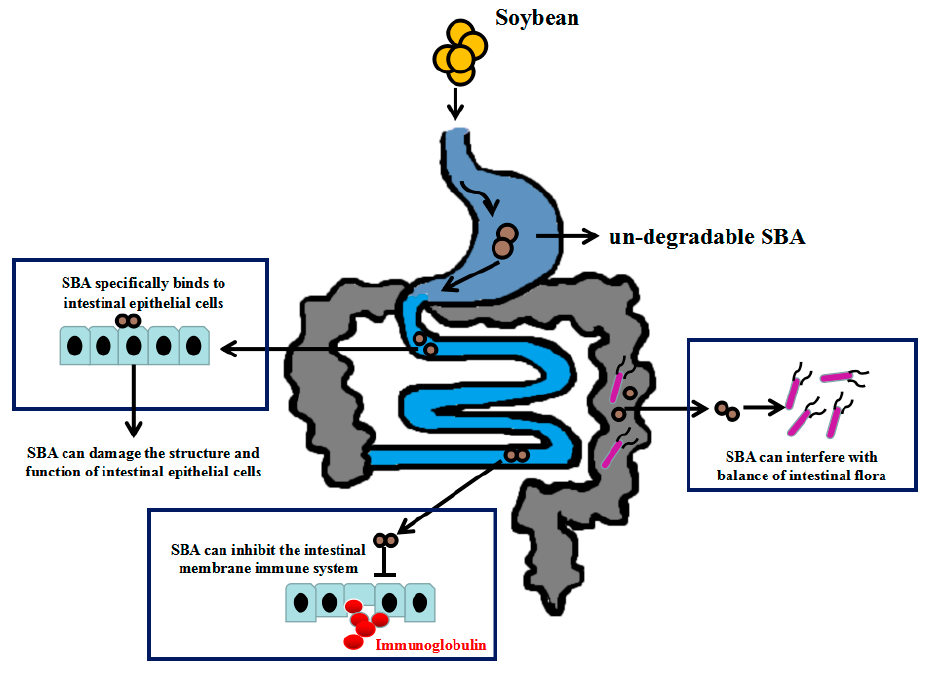
Figure 1. Anti-nutritional functions of soybean agglutinin (SBA).